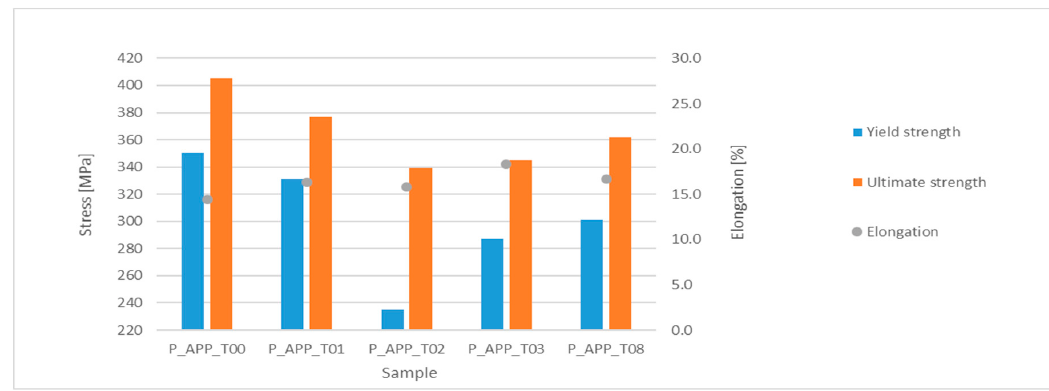
Figure 10. Results of the tensile tests performed at elevated temperature (600 °C).